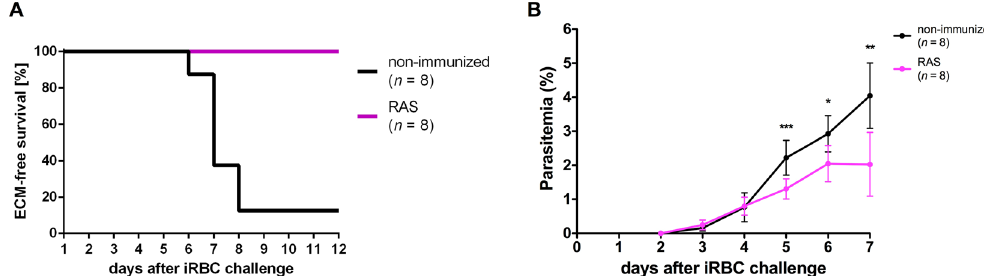
Figure 3. Protection from ECM and parasitemia in RAS immunized mice after challenge with infected red blood cells (iRBC). ( A ) A single i.v. RAS immunization (n = 8) protected animals from ECM after challenge with 10 5 iRBC ( *** P < 0.001, logrank test). ( B ) Following a challenge with 10 5 infected red blood cells, the development of blood stage parasites parasitemia was decelerated in RAS immunized mice resulting in significantly lower parasitemia on days 5 to 7 after challenge in comparison to mock-control mice ( * P < 0.05, ( ** P < 0.01, *** P < 0.001,